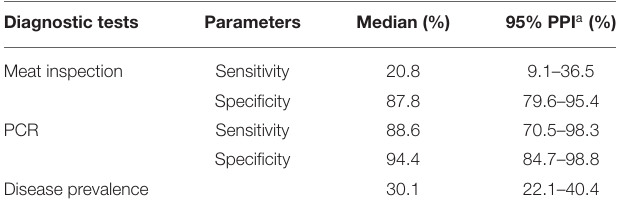
TABLE 5 | Posterior estimates for median and 95% posterior probability interval (PPI) for sensitivity and specificity of meat inspection and polymerase chain reaction (PCR) test for the diagnosis of bovine tuberculosis, and prevalence of the disease.